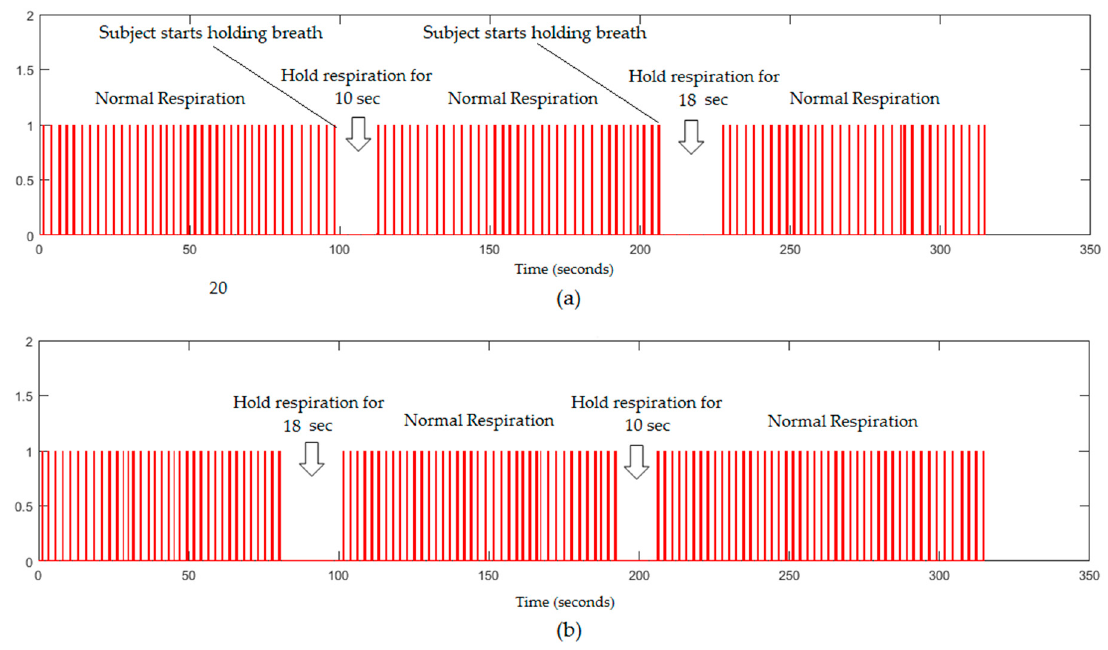
Figure 10. The respiratory signals (5 min) obtained from the proposed system in a well-lit environment, ( a ) without a blanket; ( b ) with a blanket. ( a ) without a blanket; ( b ) with a